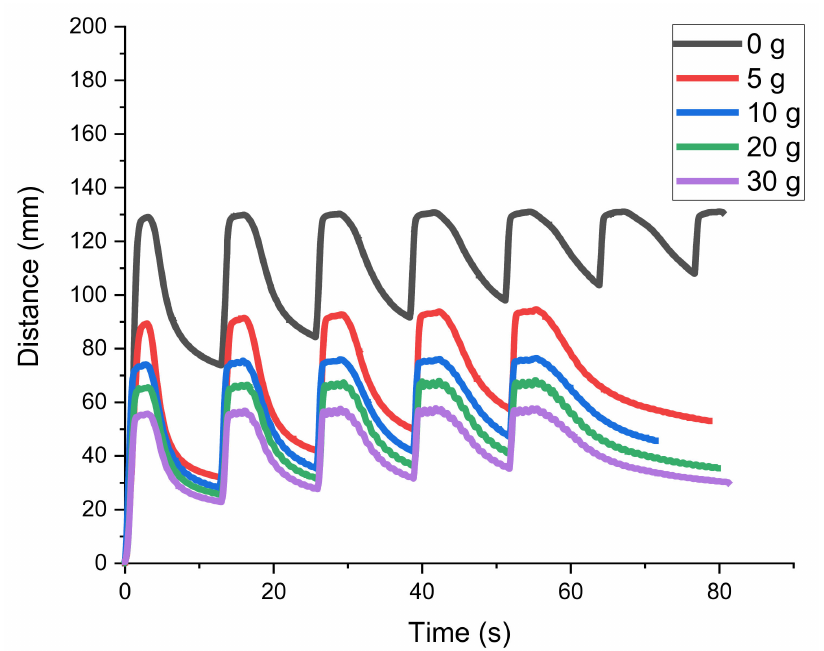
Figure 8. Actuation performance of the specimen with different weights on it at 8